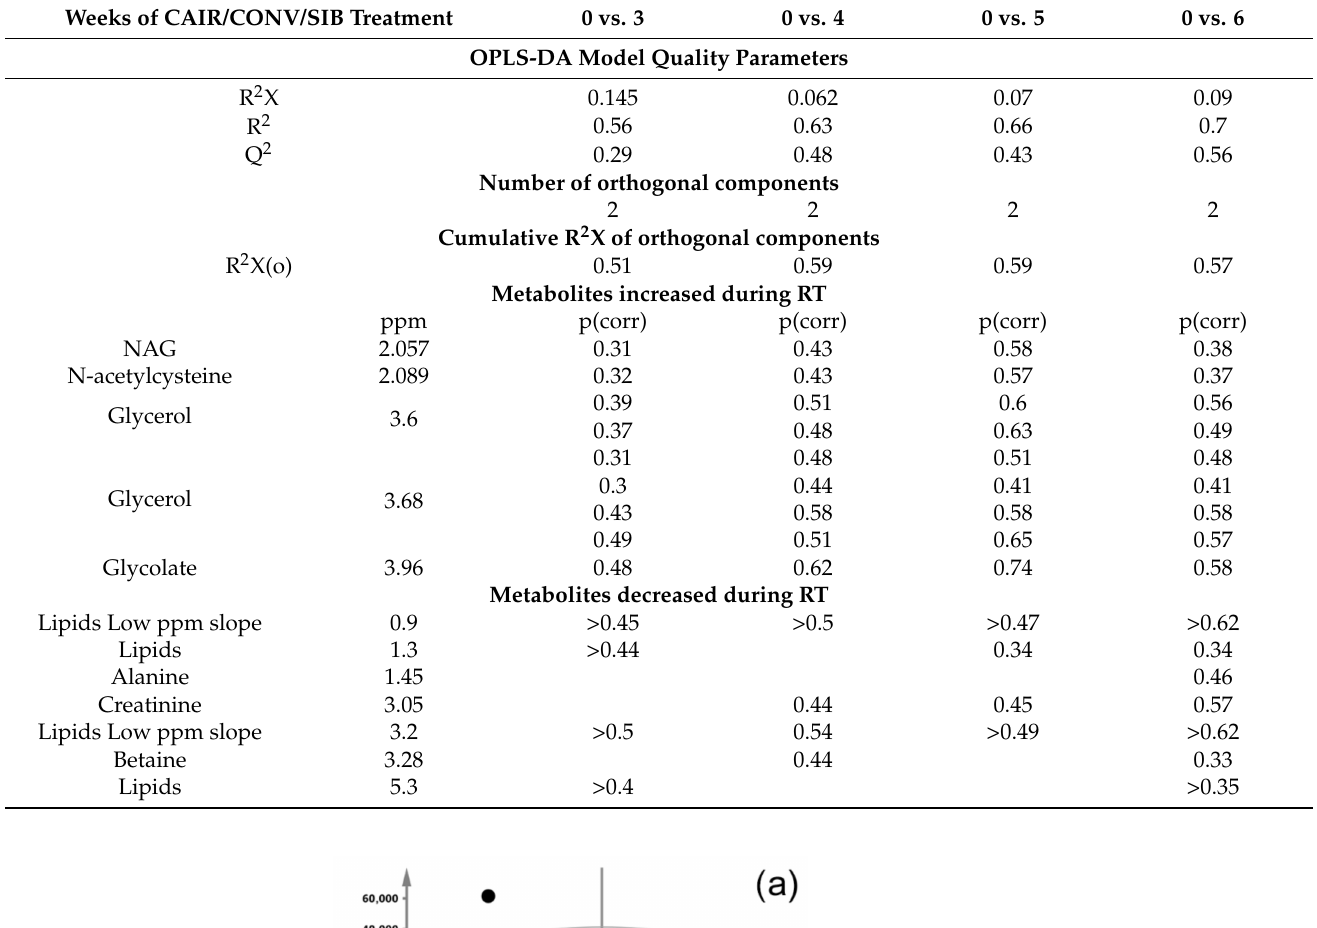
Table 2. Results from the OPLS-DA analysis of the blood serum metabolic profile changes occurring during radiotherapy of the patients receiving CAIR/CONV/SIB fractionated radiotherapy (RT).